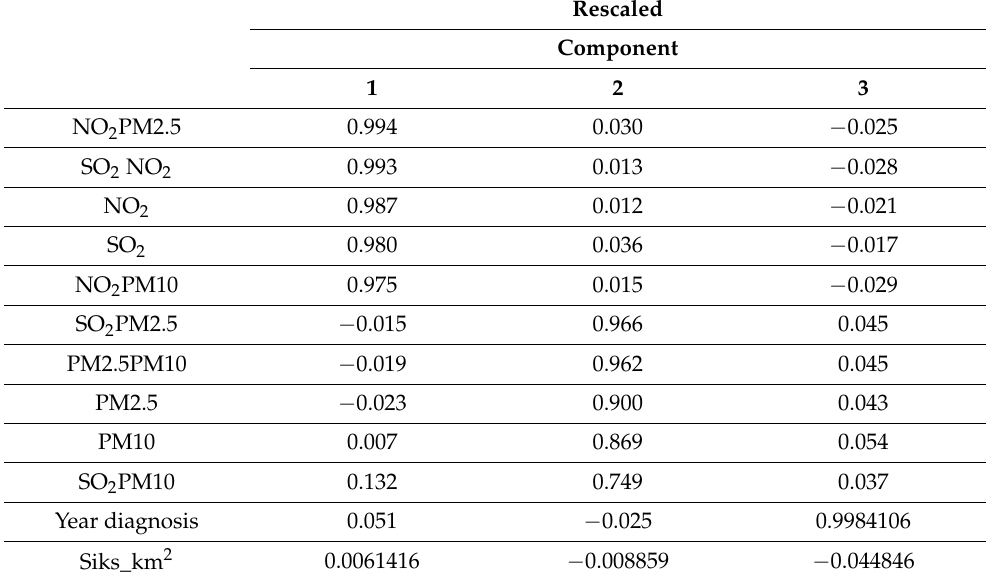
Table 4. Correlation between axes and variables (men squamous cell carcinoma).